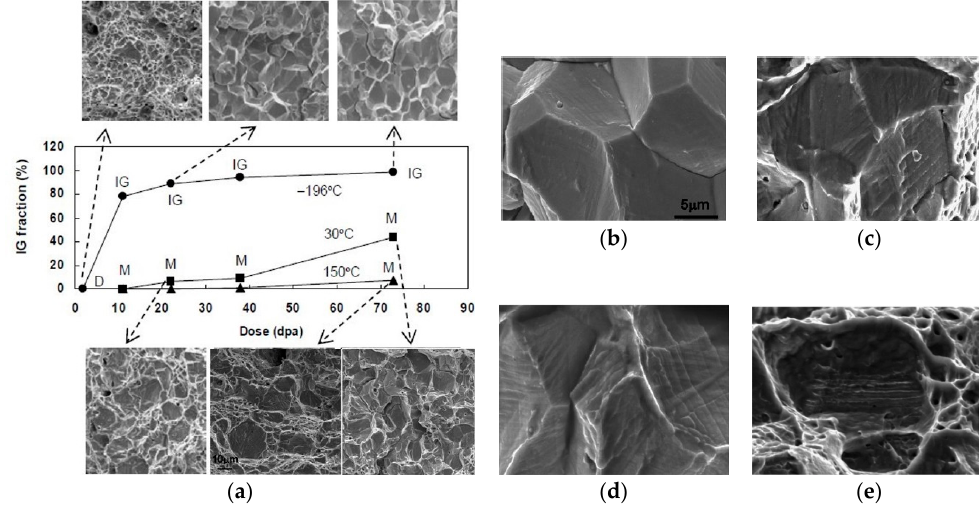
Figure 4. Fracture modes of impact tests with irradiated A316 CW (IG: intergranular, M: mixed mode, D: ductile dimple, grain size 20–30 μ m; He ~ 0.07 at. %): ( a ) Summary of IG fraction of impact tests at − 196, 30 and 150 °C showing changing fracture appearance [16] (Copyright 2009 by The Atomic Energy Society of Japan. Used with permission.); SEM micrographs showing some details of intergranular (IG) and channel facets in fracture ( b ) 73 dpa, − 196 °C, ( c ) 73 dpa, 30 °C, ( d ) 11 dpa, − 196 °C, ( e ) 38 dpa, 150 °C [17]. Reproduced with the courtesy of K. Fukuya. Elsevier reuse license has been granted.